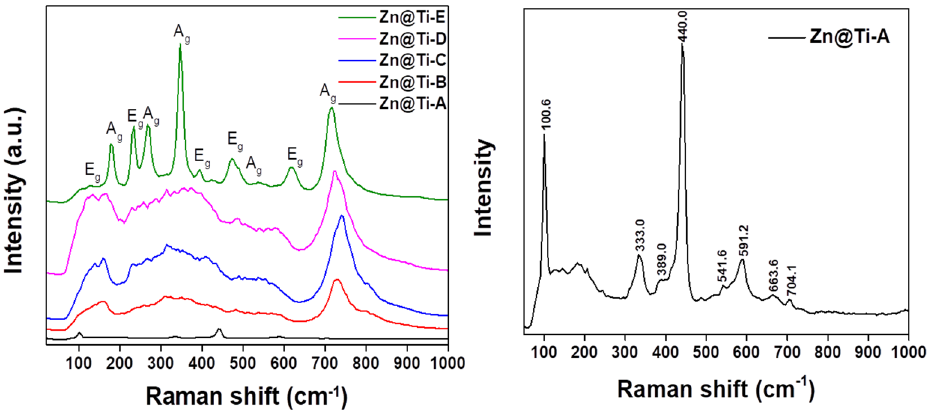
Figure 4. Raman spectra of Zn@Ti-A, Zn@Ti-B, Zn@Ti-C, Zn@Ti-D, and Zn@Ti-E nanocomposites. The right-hand figure is an enlarged image of theRaman spectrum of sample Zn@Ti-A shown in the left -hand figure.